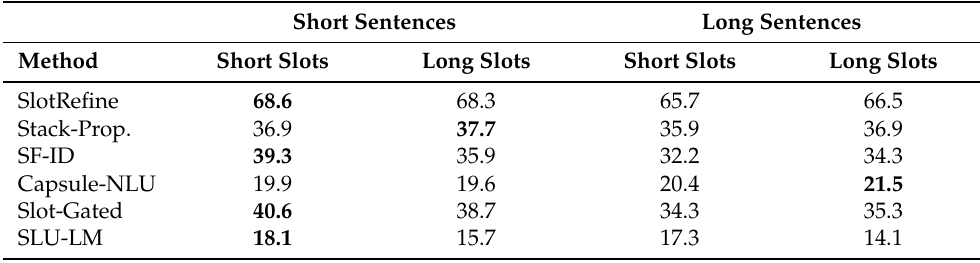
Table 6. Results for sentence-level semantic frame with joint NLU (in